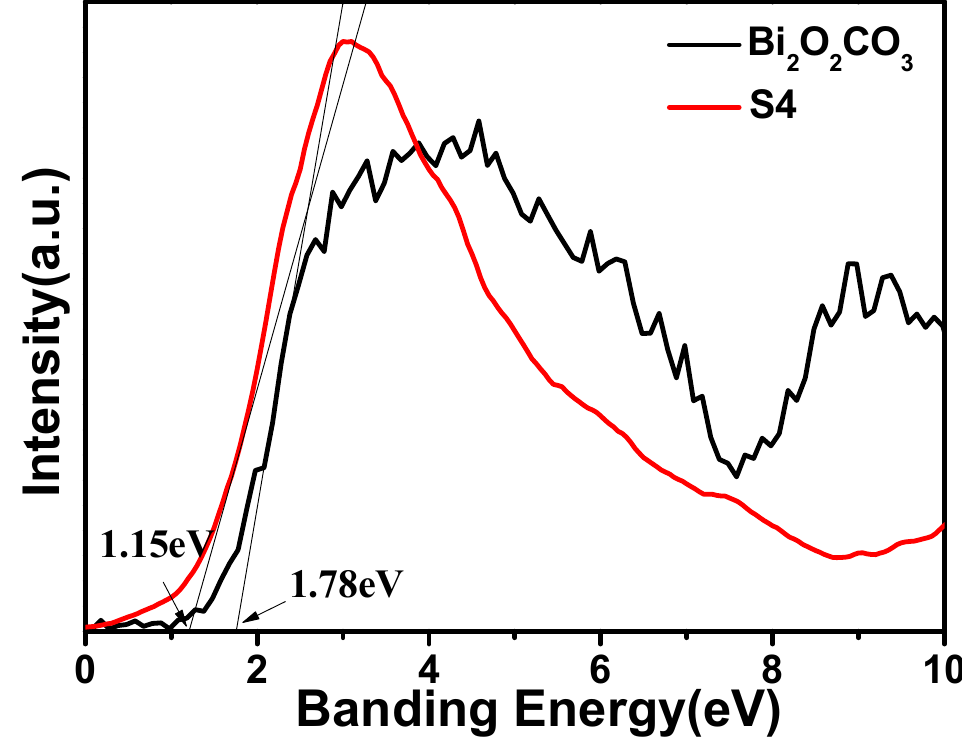
Figure 9. The VB-XPS spectra of Bi 2 O 2 CO 3 and S4 (pure BiOI). Schematic diagram for energy band of Bi 2 O 2 CO 3 –BiOI, the formation of the p–n junction and the possible charge separation is displayed in Figure 10. We know that p-n junctions can be formed between (Figure 10b), The internal electric field of Bi 2 O 2 CO 3 –BiOI p-n heterojunction promotes the migration rate of photogenerated electrons and holes, which greatly improves the photocatalytic activity. The unique vertical 2D materials on 1D structure makes BiOI nanosheets expose almost entire surface, increasing the separation and transfer rate of photo-generated electron–holes pairs. Furthermore, high-quality interface between Bi 2 O 2 CO 3 and BiOI decreases the energy barrier for the photogenerated charge carriers transfer at the junction, enhancing the photocatalytic activity.